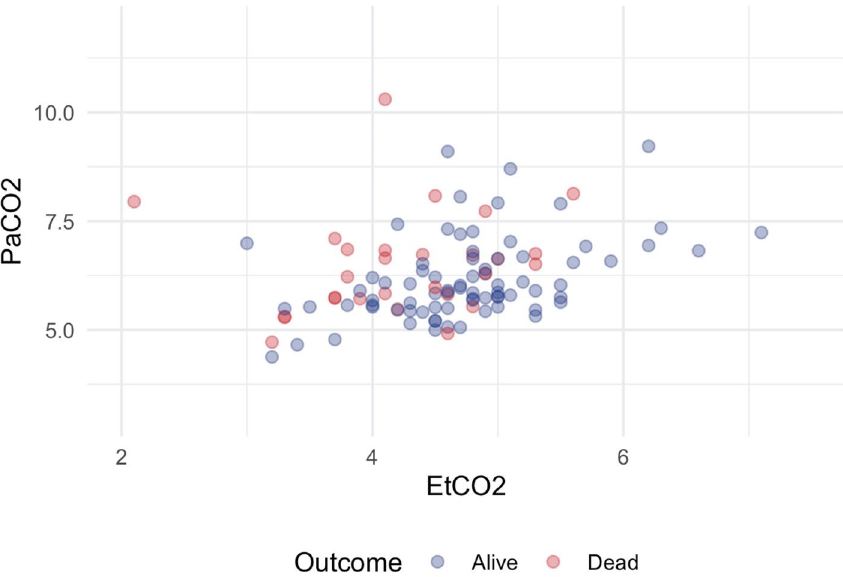
Figure 1. Correlation of PaCO2 and EtCO2. Pearson’s correlation coefficient overall r = 0.287, for survivors r = 0.438, for non-survivors r = 0.150. PaCO2 and EtCO2 in kPa. Figure was created using RStudio (2020).